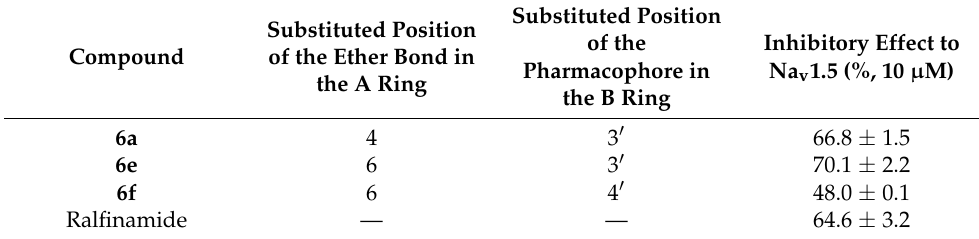
Table 6. Inhibitory activity of the compounds against Na v